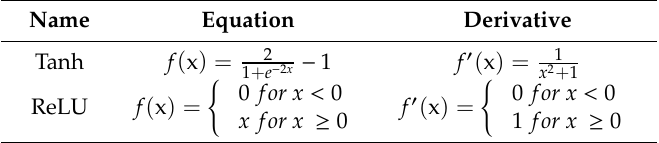
Table 2. Functions used in the artificial neural network hidden